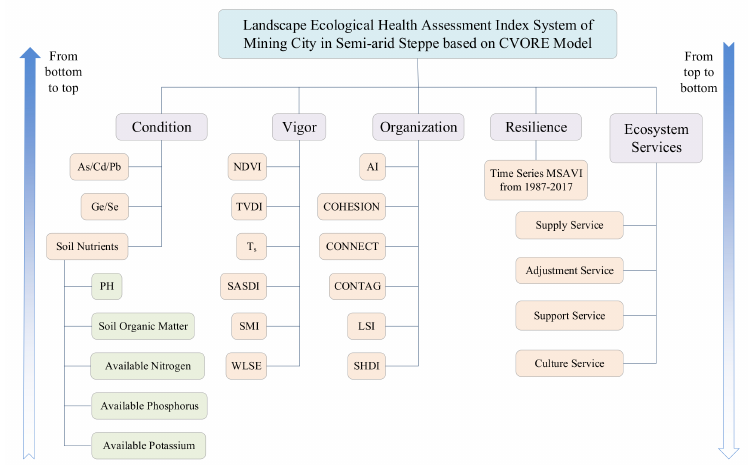
Figure 1. Landscape ecological health assessment index